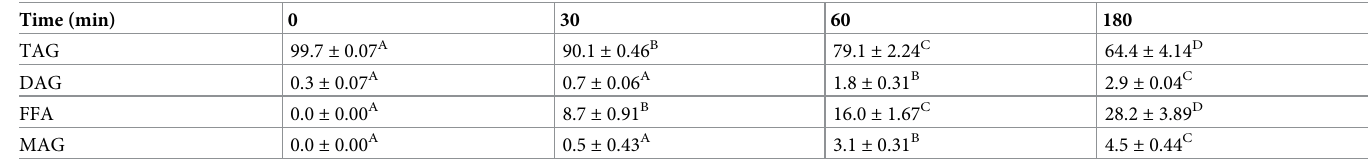
Table 4. Lipid class composition (weight percent) of cod-liver oil (time 0) and changes during in vitro digestion (n = 3).